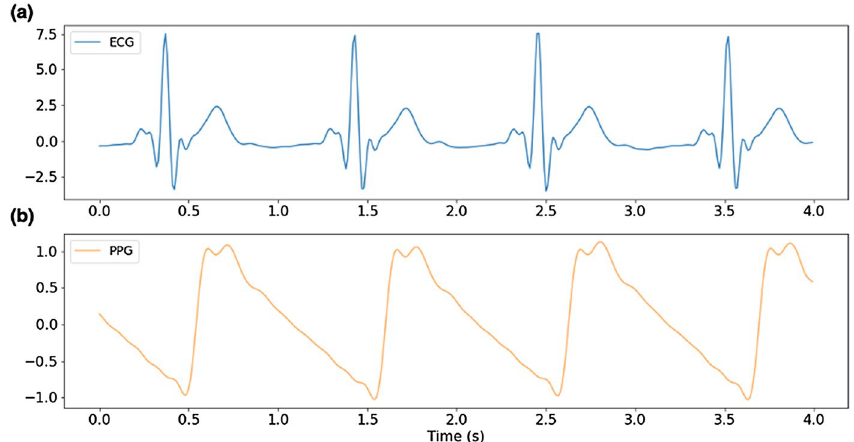
Figure 1. Examples of input waveforms for 1D V-Net model. ( a ) 4-s sample of electrocardiogram (ECG) waveform and ( b ) a 4-s sample photo-plethysmograph (PPG)